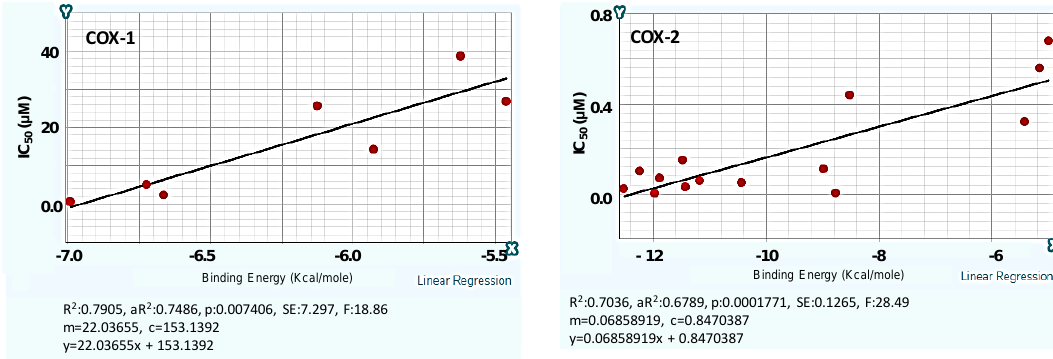
Figure 2. Correlation of the predicted binding energy in kcal/mole with the experimentally calculated IC 50 value of inhibitory action of the reference compounds E1 – E14. against COX-1 ( left ) and COX-2 ( right ).